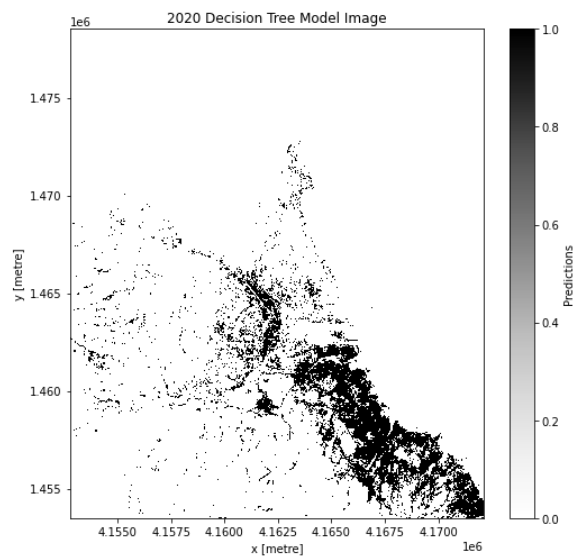
Figure 5. Decision tree model shows less vegetation in 2020.